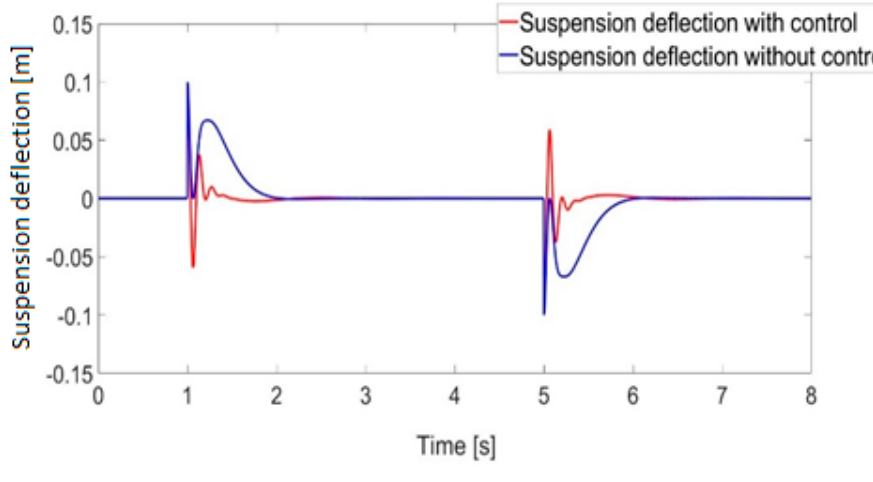
Figure 3. Suspension deflection.